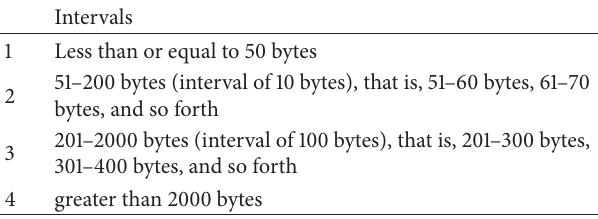
Table 2: Interval setting strategy for frame